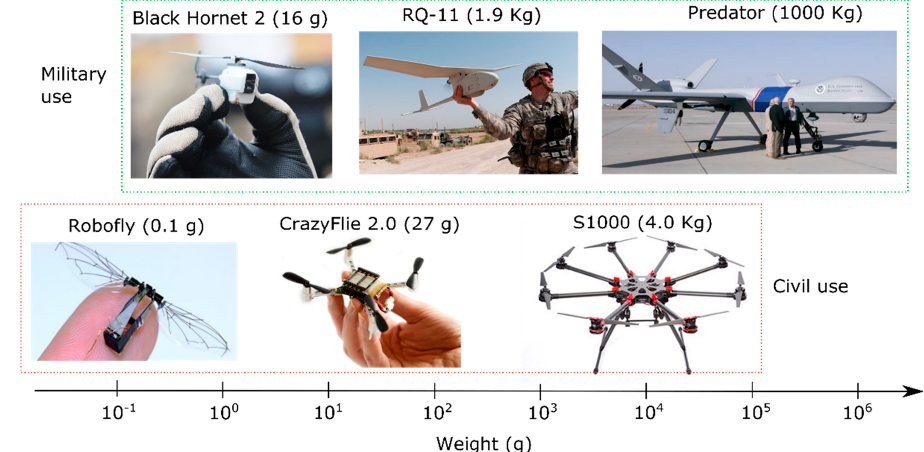
Figure 1. Overview of the UAV landscape, from insect-sized drones to military aircrafts, classified according to the approximate weight and size. The graphic shows the large range of UAV sizes, which spans seven orders of magnitude.